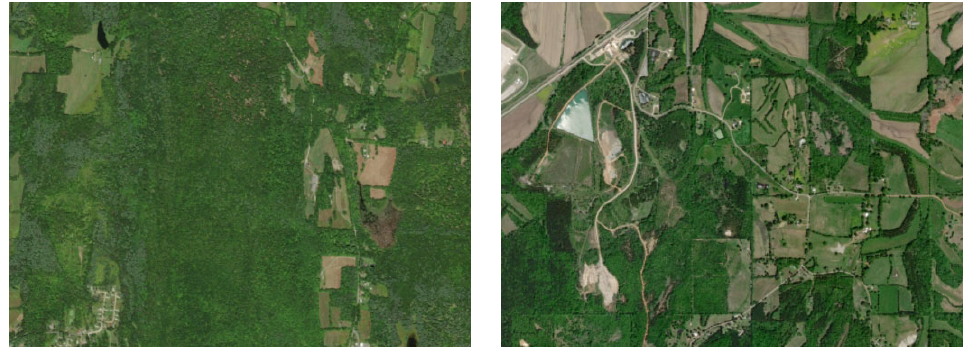
Figure 16. Typical “forest” (FR) and “mix” (MX) terrain views.